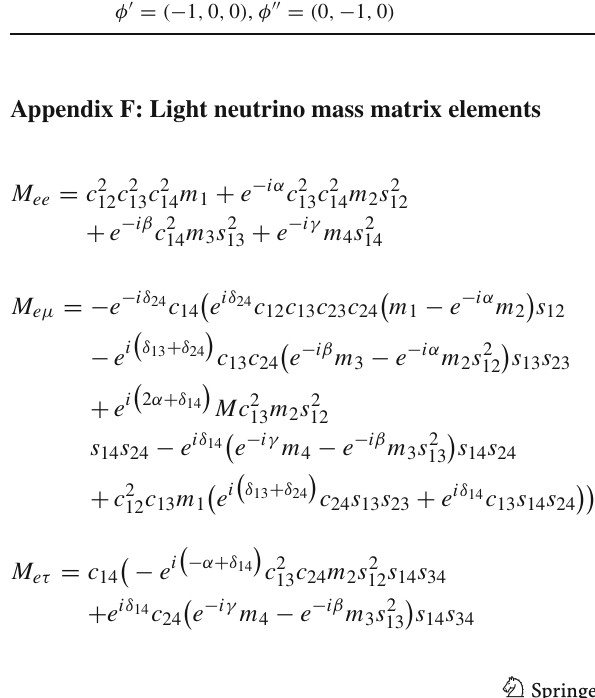
Table 20 VEV alignment of triplet flavon fields φ (cid:3) , φ (cid:3)(cid:3) for texture 1 zero symmetric case, that give rise to same complex constraints Sl no.